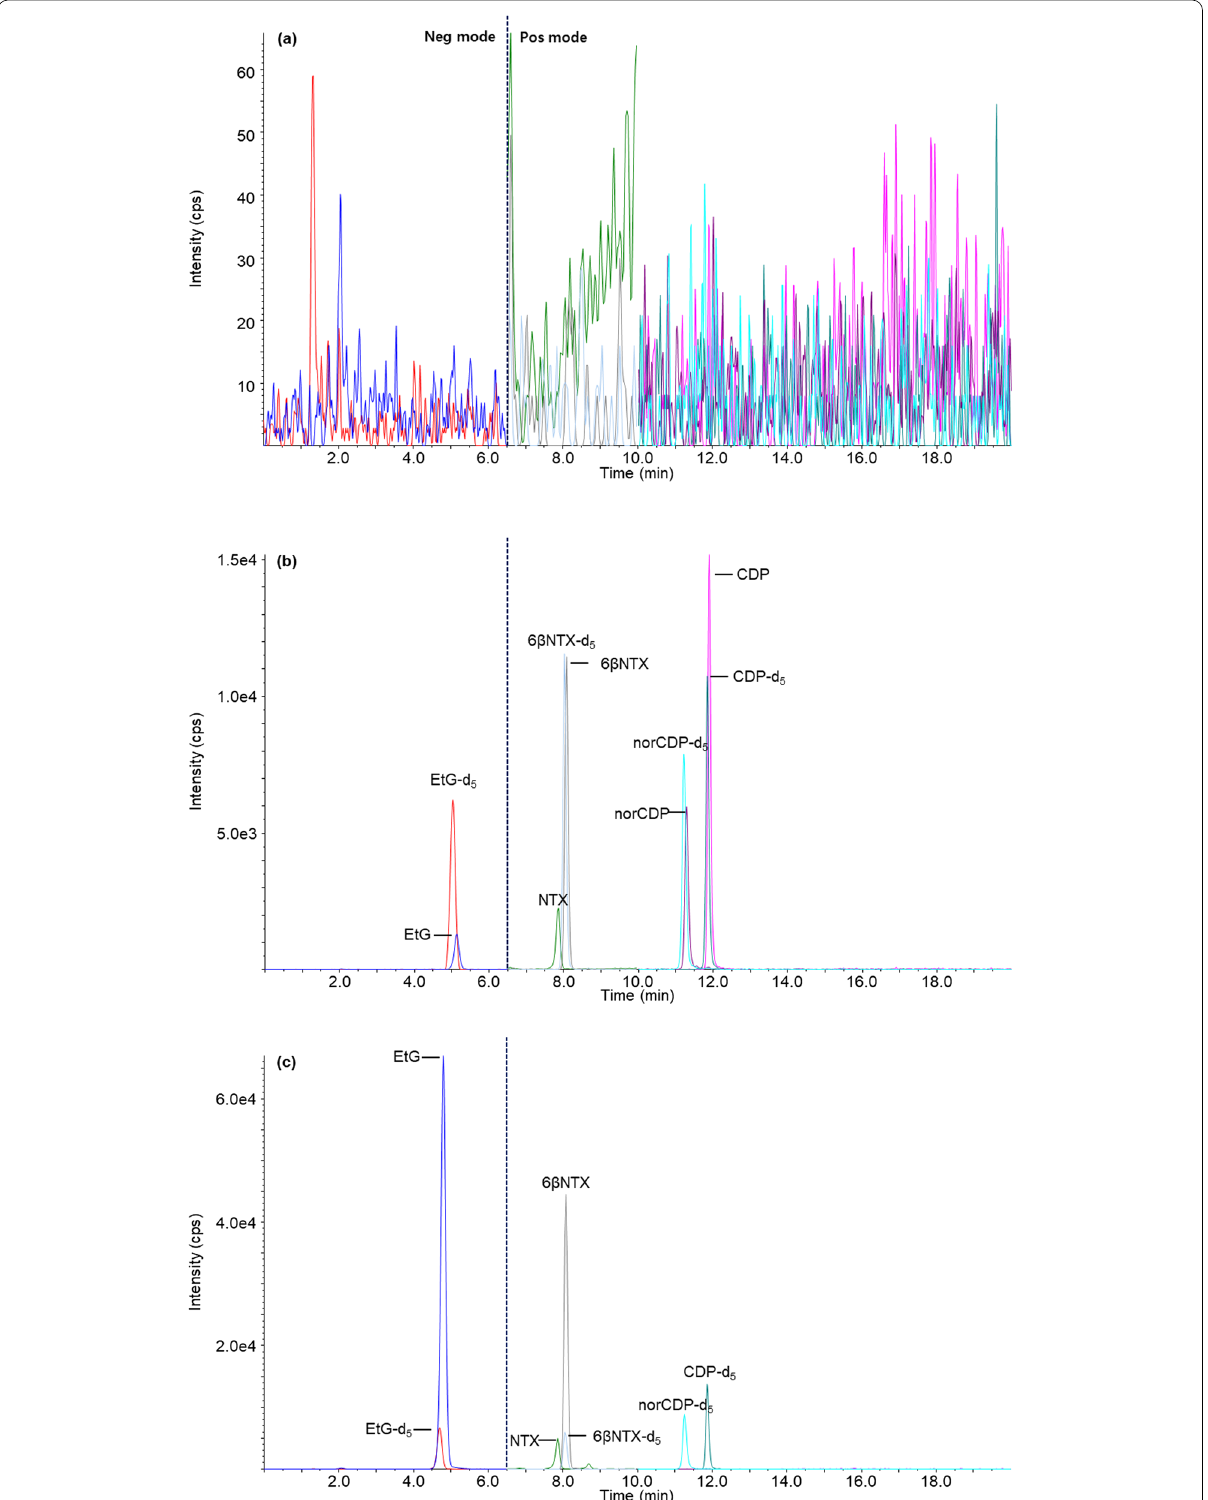
Fig. 3 Representative LC–MS/MS MRM chromatograms obtained from a blank urine, b spiked urine containing 50 ng/mL of EtG, 6βNTX, CDP, and norCDP, and 10 ng/mL of NTX, and c NTX-positive urine